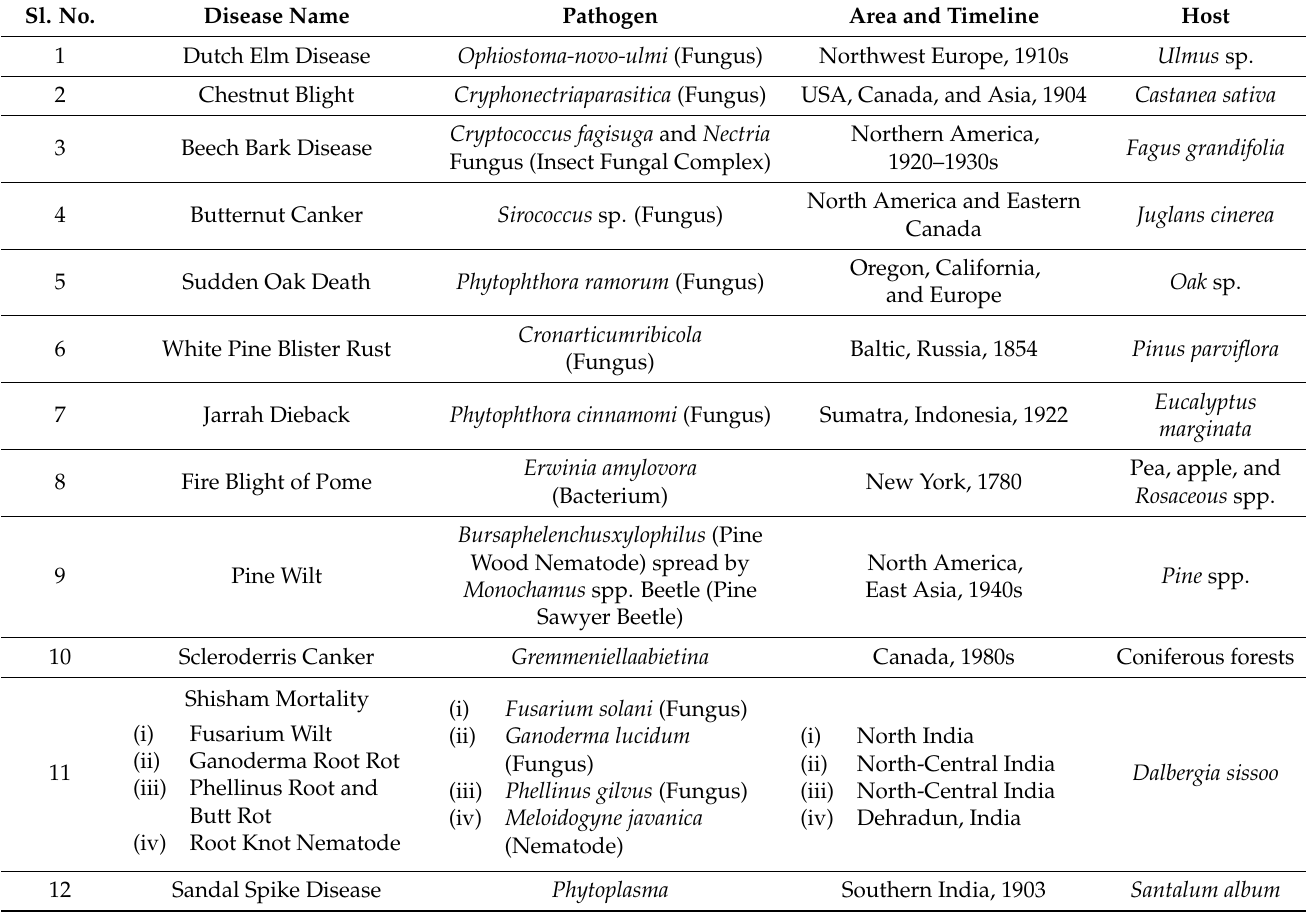
Table 1. Major historical outbreaks of forest tree diseases across the world